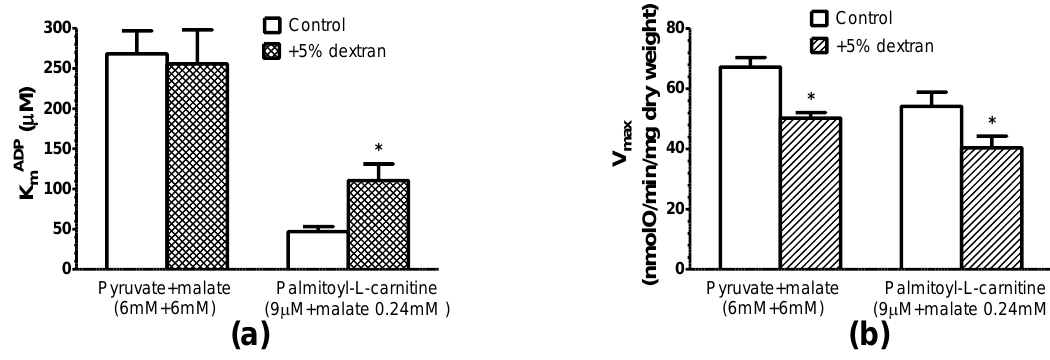
Figure 11. Influence of 5% dextran T70 on the apparent K mADP ( a ) and V max ( b ) of saponin- permeabilized rat cardiac fibers using different respiratory substrates. n = 5 (paired), 37 °C, * p < 0.05 versus control. The results were analyzed with one-way analysis of variance (ANOVA) followed by a Dunnett post hoc test.